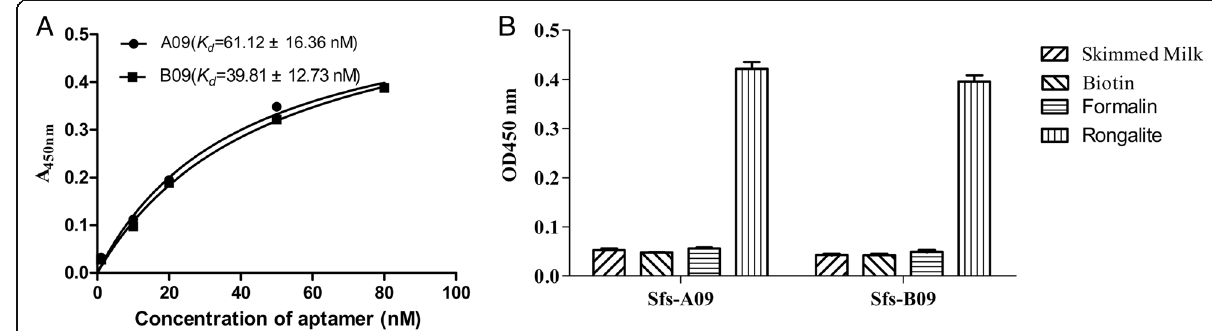
Fig. 4 a Measurement of the K d value of A09 and B09. GraphPad Prism was used to perform nonlinear cure fitting analysis for K d calculation. b The specific binding affinity between A09/B09 and